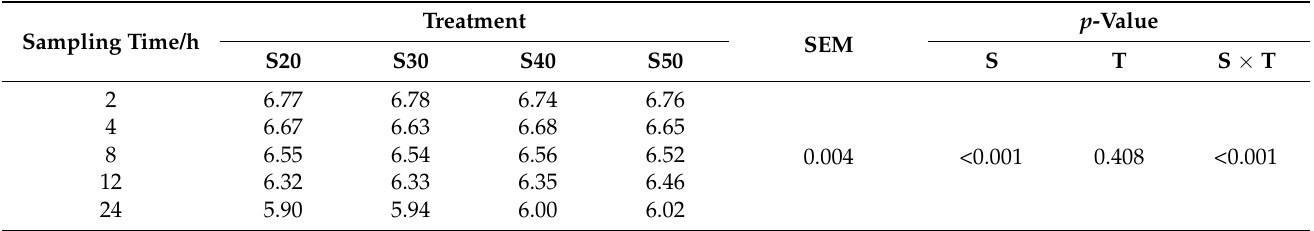
Table 2. The effect of substrate SP (% of CP) levels on pH value at different sampling times in vitro. p -Value Treatment Sampling Time/h SEM S20 S30 S40 S50 S T S ×